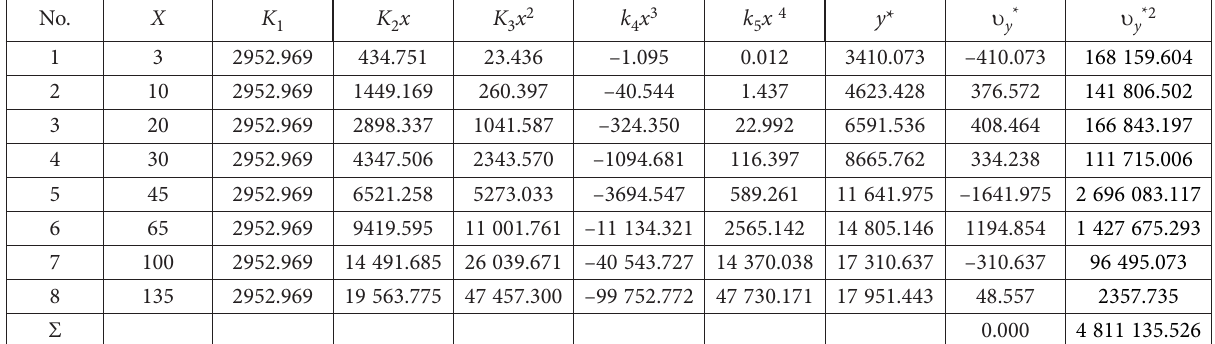
Table 7. Estimation of the approximation accuracy by the Chebyshev method